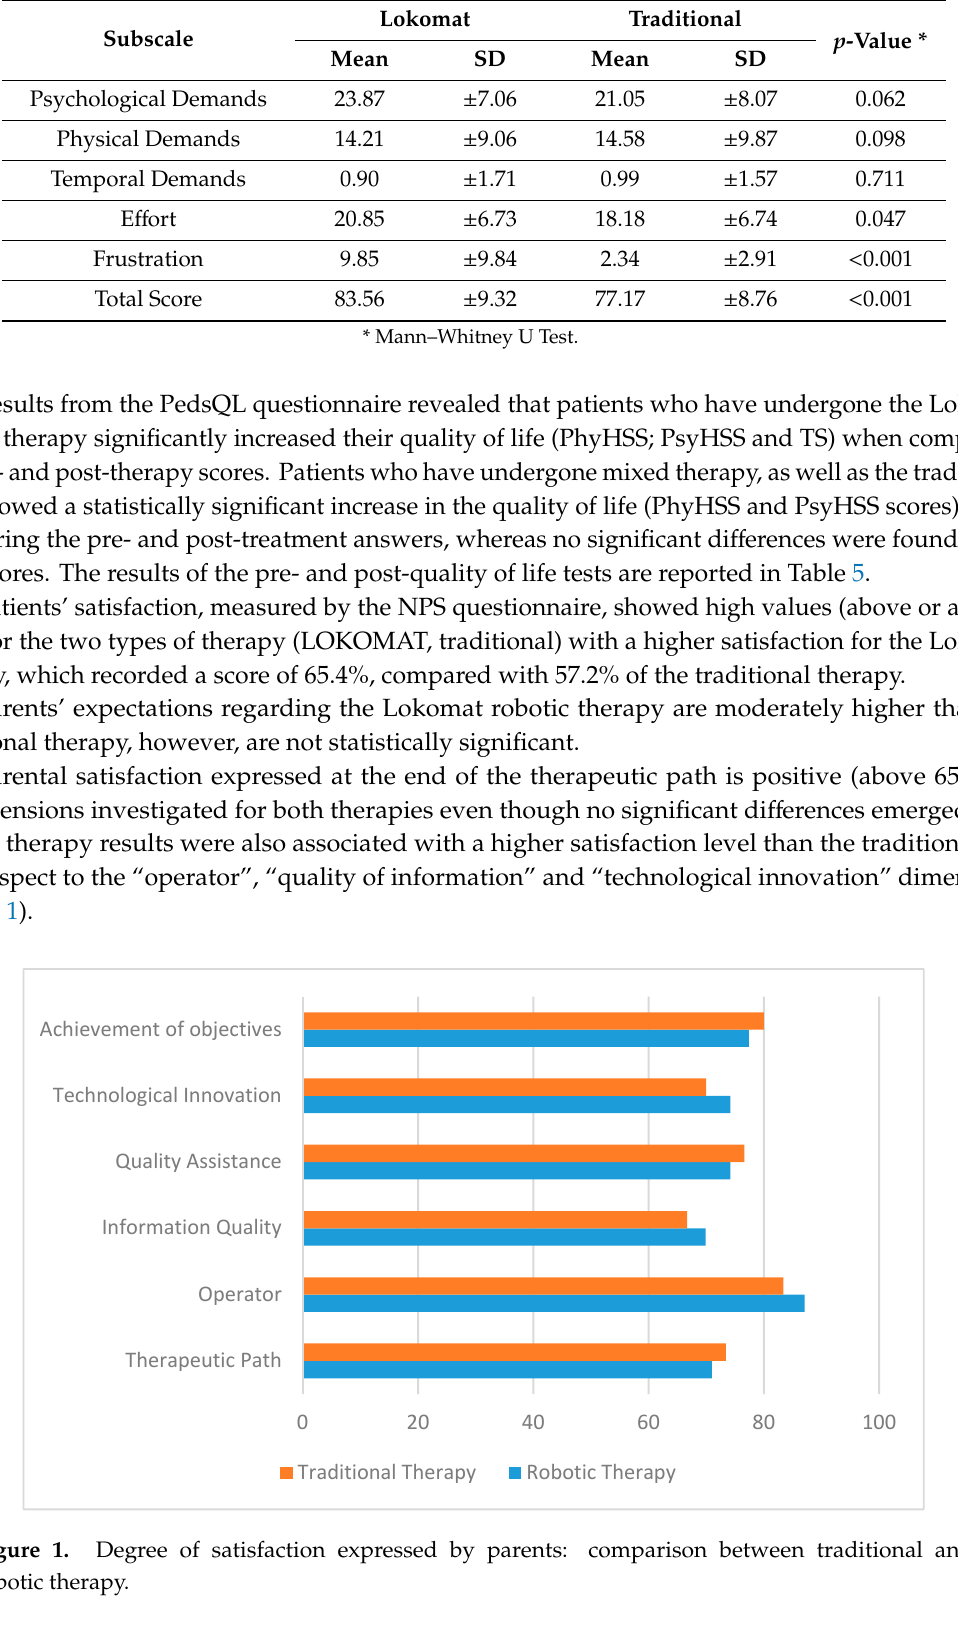
Table 4. Physiotherapists’ workload (NASA-TLX questionnaire).